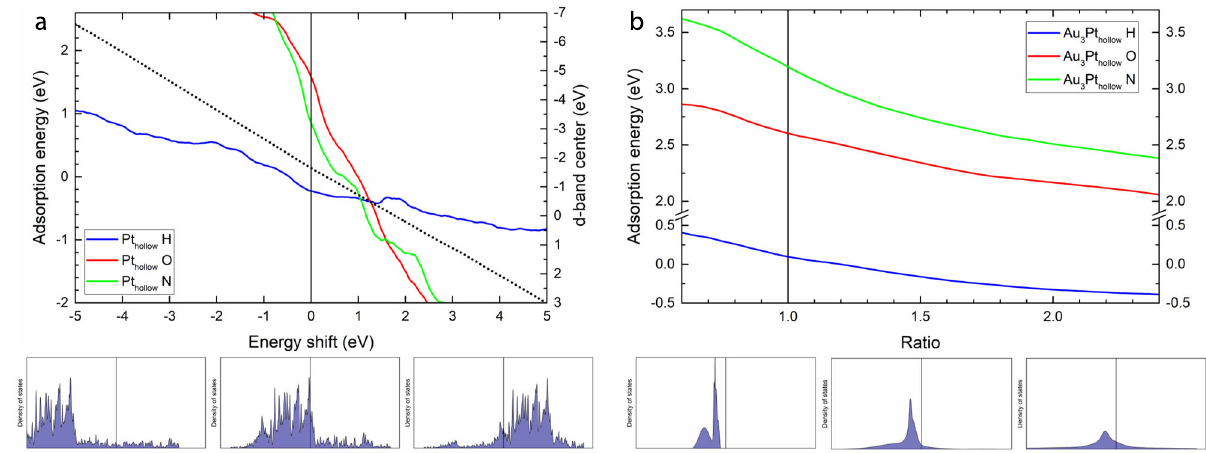
Fig. 6 Effect of d -band changes on predicted adsorption energy. a Effect of d -band position on adsorption energy for the case of the Pt hollow site. b Effect of d -band width on adsorption energy for the case of the Au 3 Pt